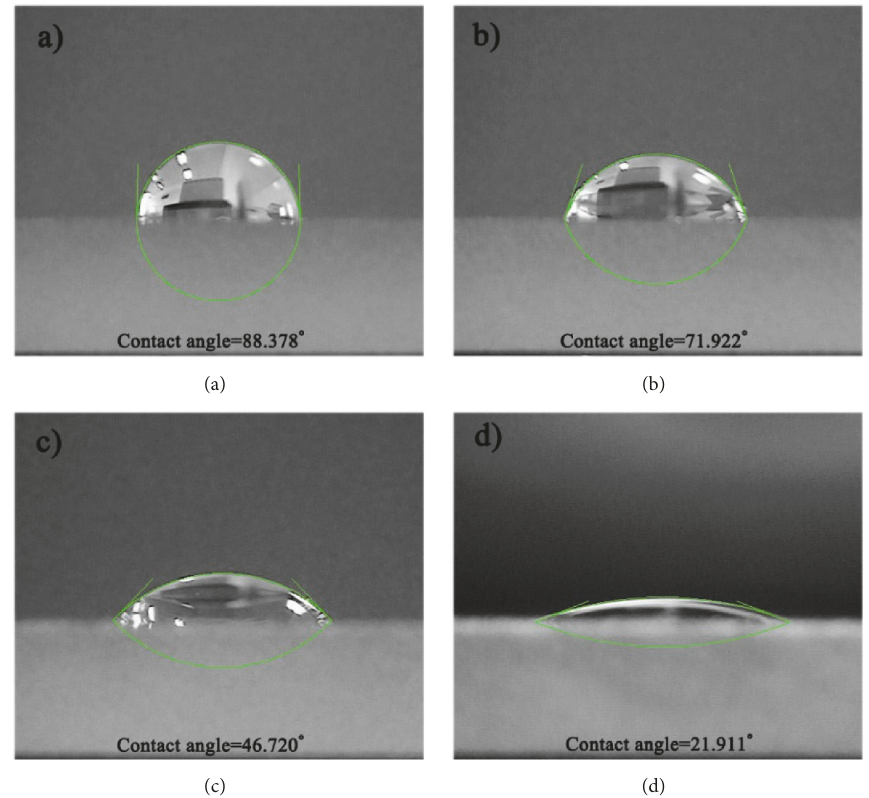
Figure 4: Contact angle measurement: (a) bare Au film; (b) Au film after 20 min UV exposure; (c) Au/cysteamine SAM; (d) Au/cysteamine/ biotin film.